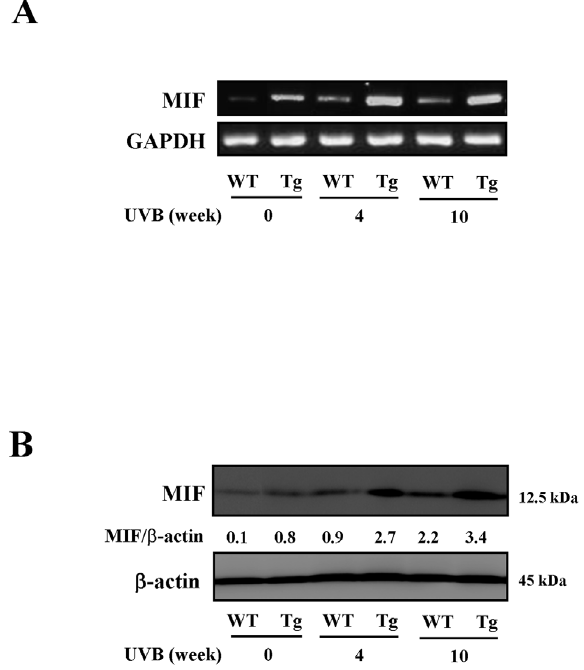
Figure 1. Enhanced expression and production of MIF in the MIF Tg mouse skin following chronic UVB exposure. The total RNA and protein were isolated at 0, 4 and 10 weeks after UVB irradiation (300 mJ/cm 2 6 3/week). (A) The expression of MIF mRNA was examined by RT-PCR. (B) A Western blot analysis was performed, and b - actin was used to normalize each expression level. A densitometric analysis was also performed to quantify the intensity of each band. (Each experiment was repeated two times with similar results).